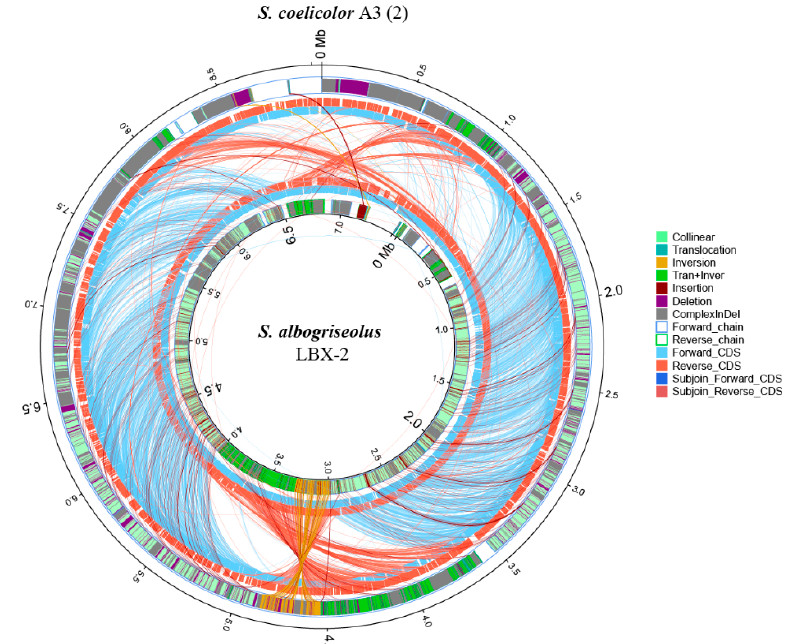
Figure 8. Synteny comparison of S. albogriseolus LBX-2 genome with the genome of the type strain S. coelicolor A3(2). Outer circle: S. coelicolor A3(2) genome; Inner circle: S. albogriseolus LBX-2 genome; Collinear: collinear region; Translocation: translocation region; Inversion: Iinversion region; Tran + Inver: translocation and inversion region; Insertion: insertion region; Deletion: deleted region ( ≥ 50 bp); Complex Indel: the region that corresponds to a position but cannot be compared; Forward chain: the forward chain of the genome sequence, the gene coordinates increased clockwise; Reverse chain: the reverse chain of the genome sequence, the gene coordinates increased counterclockwise; Forward CDS: CDS translated from the forward chain; Reverse CDS: CDS